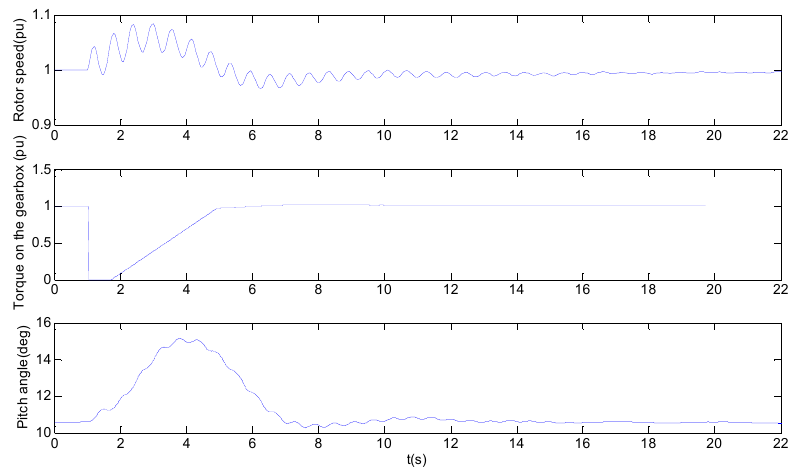
Figure 12. Rotor speed, torque on the gearbox high speed shaft and pitch angle.